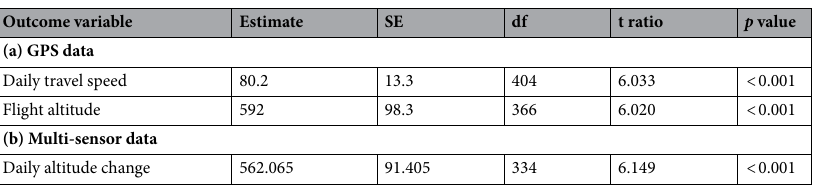
Outcome variable Estimate